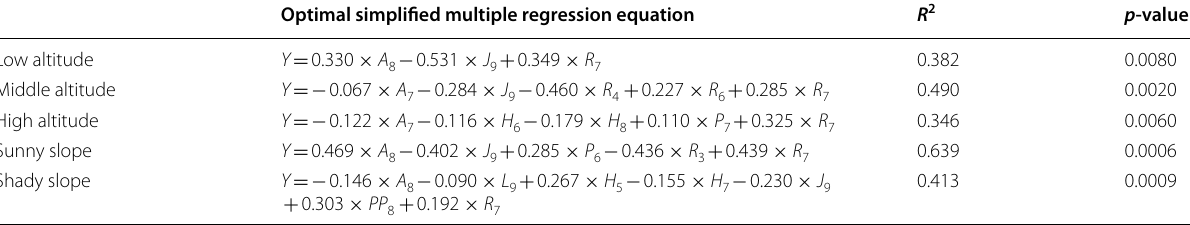
Table 3 Optimal simplified multiple regression model for growth-climate of L. olgensis